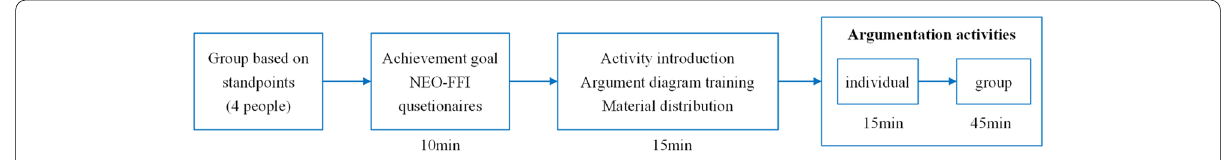
Fig. 1 Argumentation activity